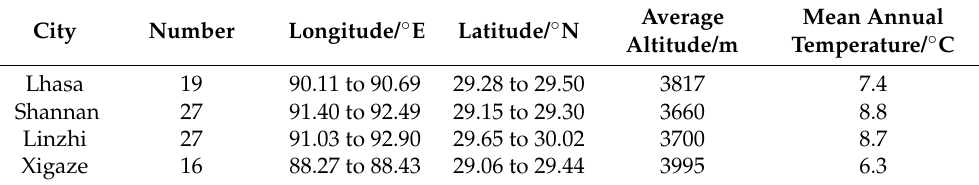
Figure 1. Geographical map of chicken sampling sites from Tibet. Table 1. Region information of Tibetan chicken